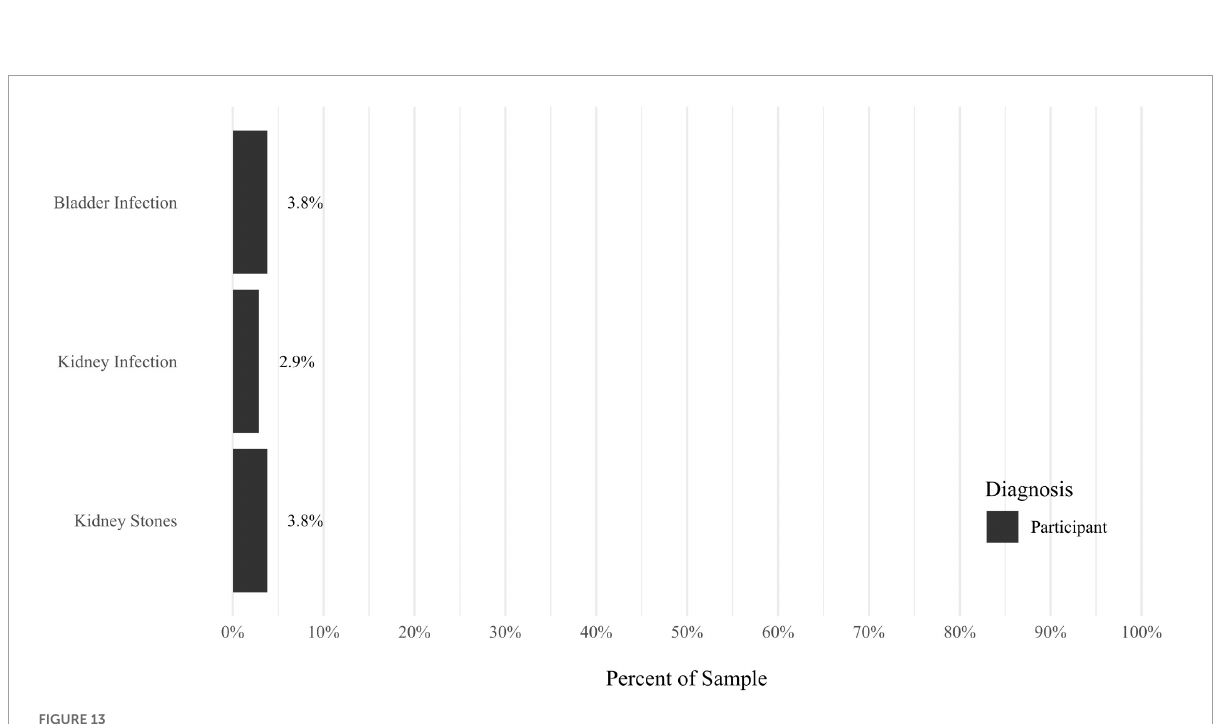
FIGURE13 Rates of medical health problems: kidney